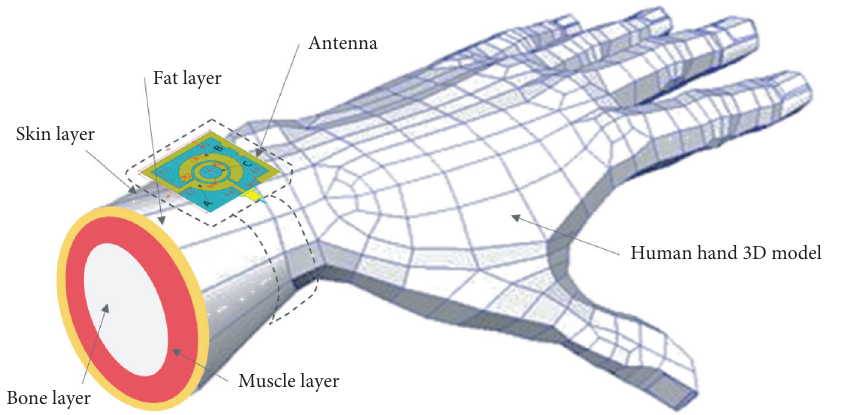
Figure 15: SAR simulation setup.